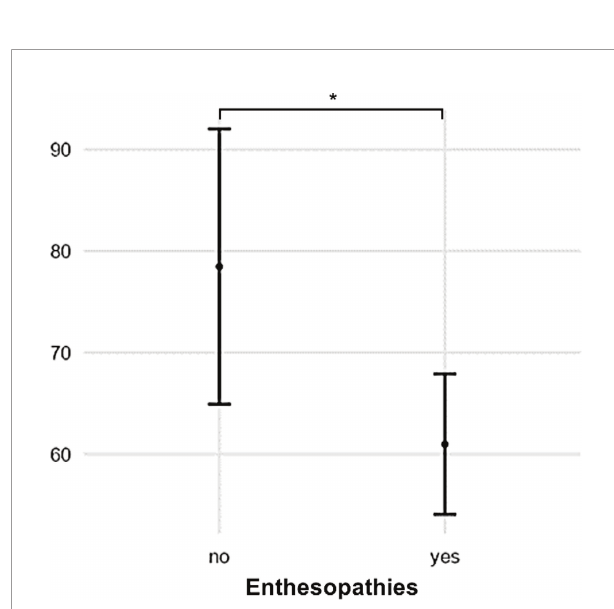
FIGURE 5 | Patients with radiographic signs of enthesopathies had low GDI scores compared with those without (p = 0.022). (* = p >